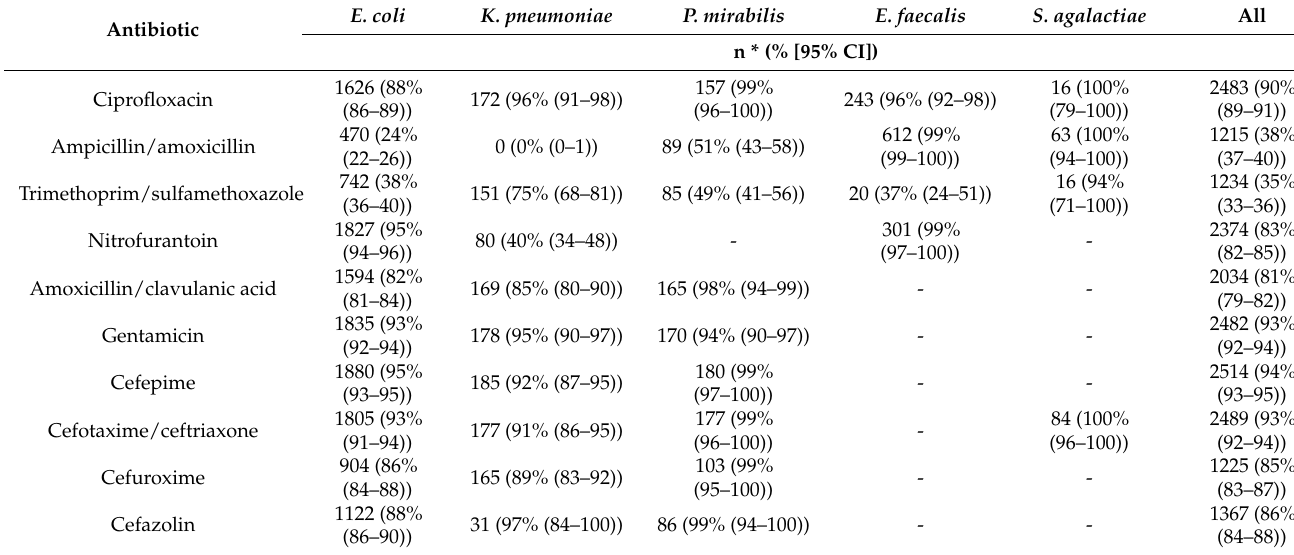
Table 1. Antimicrobial susceptibility of predominant uropathogens among cases of culture-confirmed urinary tract infection in antenatal clinics at four tertiary public-sector hospitals in Gauteng Province, 2015–2019.